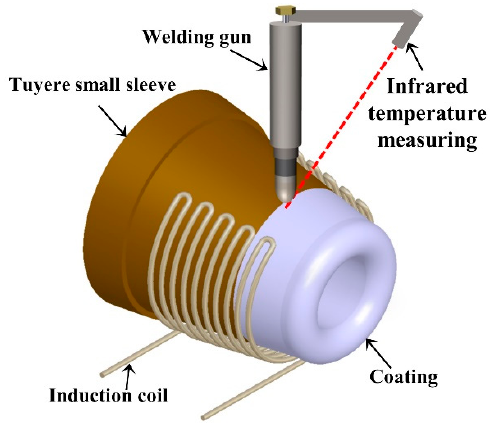
Figure 16. Schematic diagram of cladding process for tuyere small